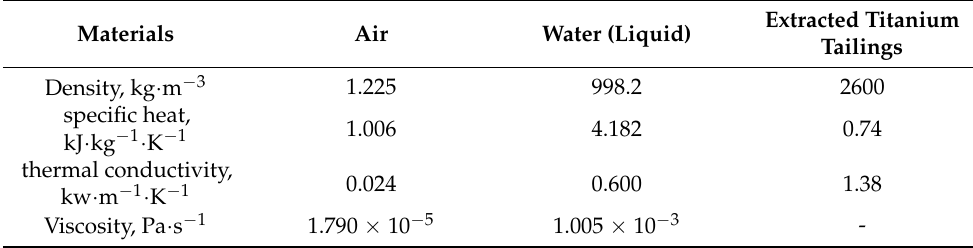
Table 1. Physical parameters of materials at 298